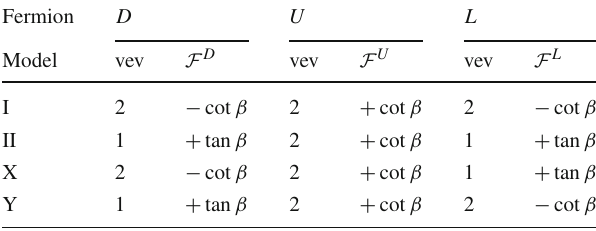
Table 6 Relevant vacuum expectation values, for (cid:4) 1 or (cid:4) 2 , denoted 1 and 2, and reduced Yukawa couplings F , as defined by Eq. (B.2) for models without tree-level